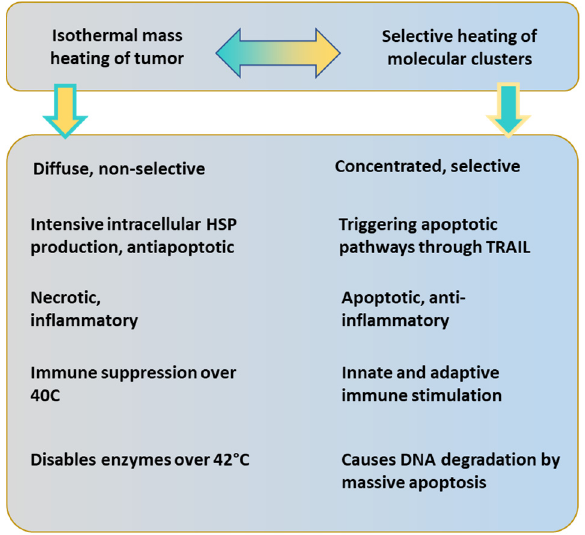
Figure 15. The major differences between isothermal and selective paradigm heating are listed in the columns.